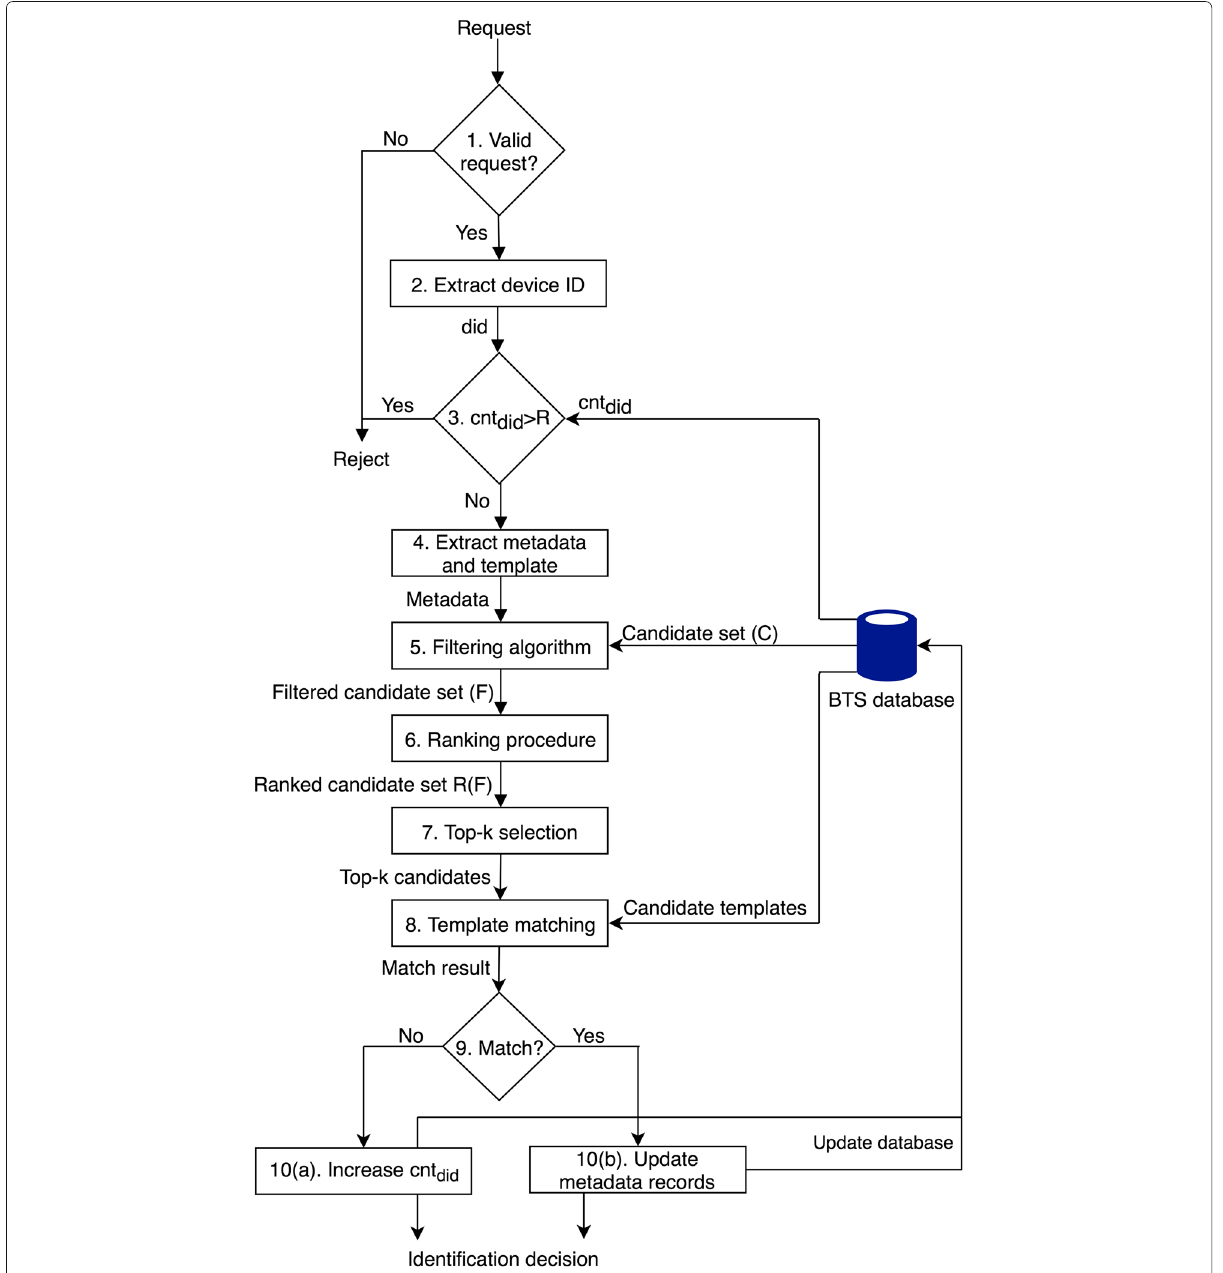
Fig. 3 Illustration of generic metadata